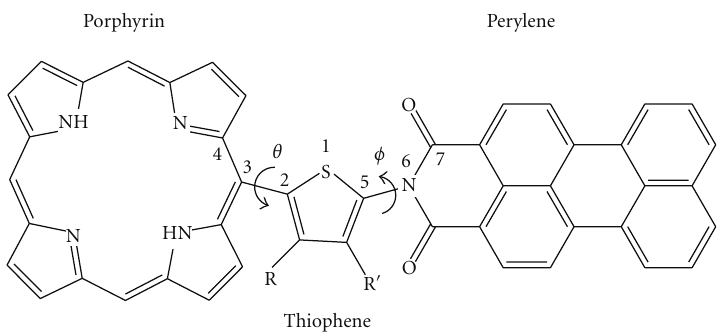
Figure 1: Two-dimensional structure of the PTP sensitizer compound (R = R (cid:2) = –H) and its derivatives where (i) R = –H, and R (cid:2) = –H, –CH 3 , –OCH 3 , –OH, –NH 2 , –N(CH 3 ) 2 , –CN, or –NO 2 ; (ii) R = –H, –CH 3 , –OCH 3 , –OH, –NH 2 , –N(CH3) 2 , –CN, or –NO 2 ; and R (cid:2) = –H; (iii) R = R (cid:2) = –H, –CH 3 , –OCH 3 , –OH, –NH 2 , –N(CH 3 ) 2 , –CN, or –NO 2 . The torsion angles, θ and φ , were defined by 1-2-3-4 and 1-5-6-7,